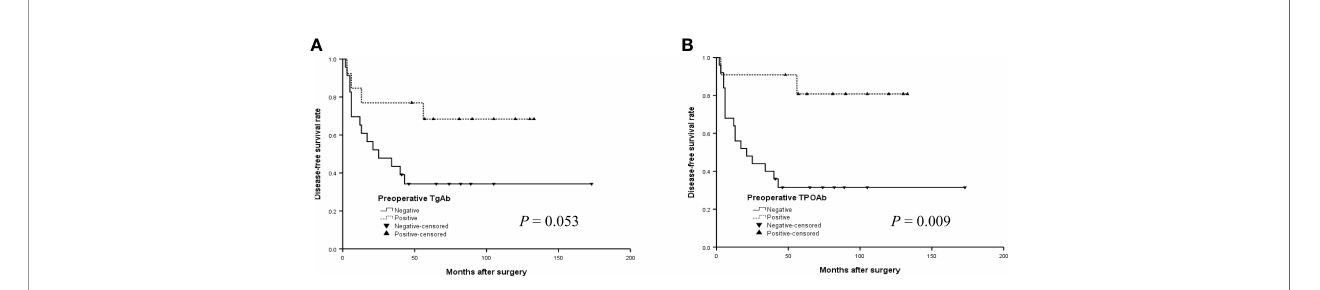
FIGURE 2 | The disease-free survival (DFS) curves of the positive or negative preoperative TgAb (A) and TPOAb (B) in the younger group (< 14 years) with PTC.